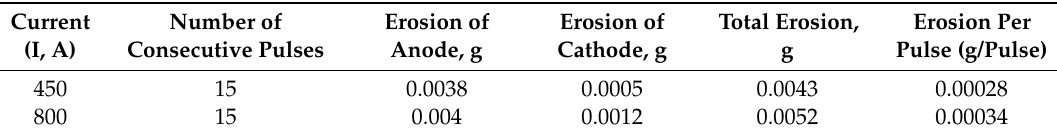
Table 2. Erosion of the copper electrodes after the carried out